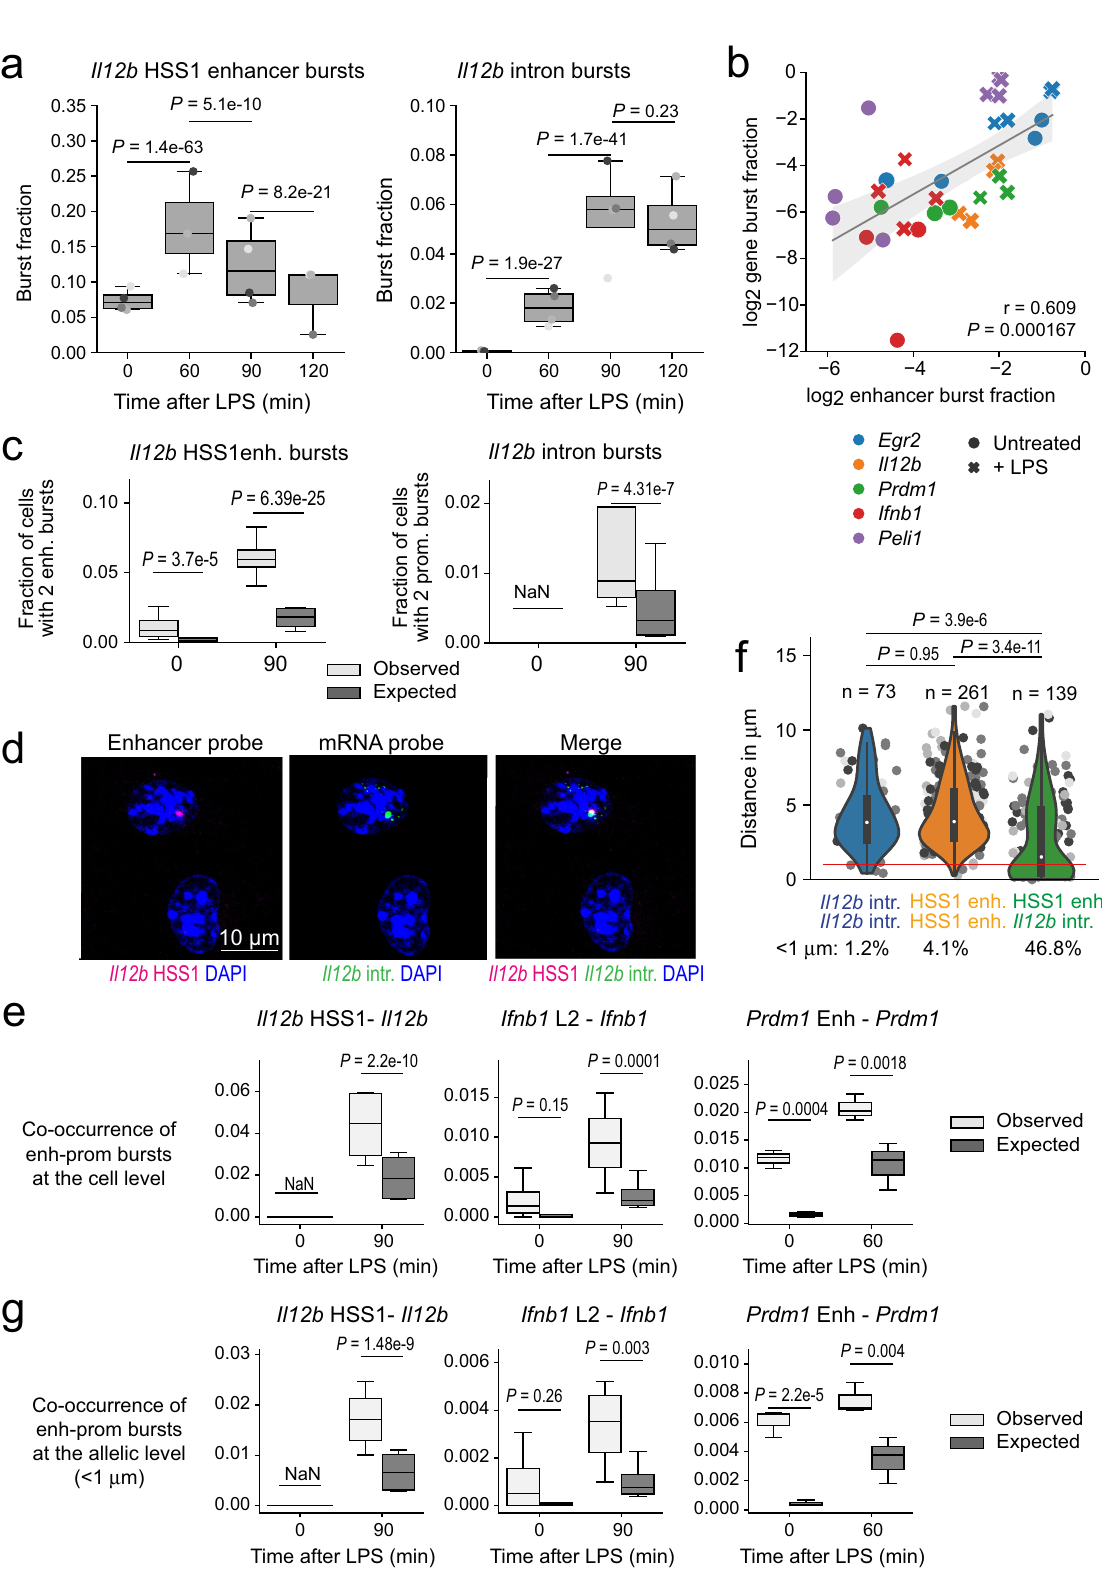
(Fig. 7a). The Il12b HSS1 enhancer, Prdm1 enhancer and Peli1 enhancer displayed higher burst fractions in Rad21 − / − compared to wild-type macrophages (Fig. 7a). The Egr2 enhancer was sig- ni fi cantly induced in Rad21 − / − macrophages, albeit to lower levels than in wild-type macrophages (Fig. 7a). In contrast to enhancer burst fractions, the promoter burst fractions of Il12b ,